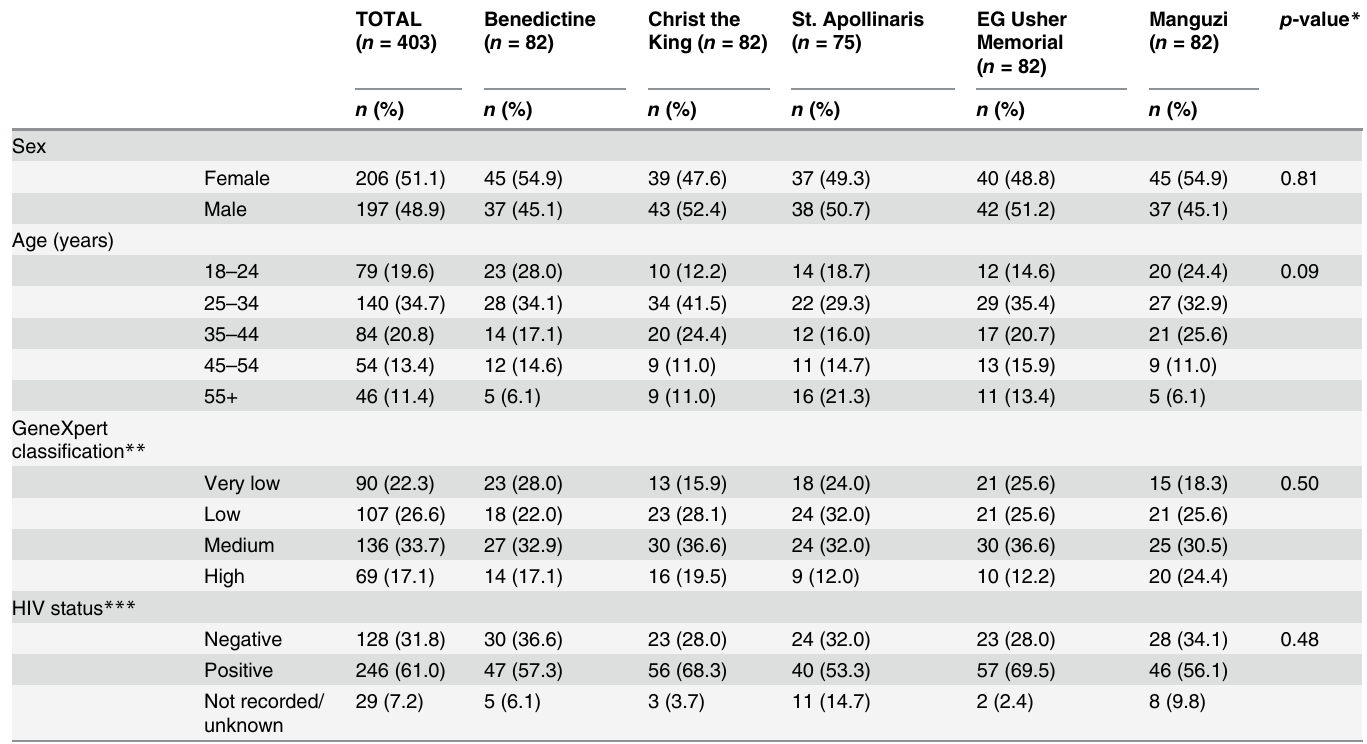
Table 5. Participant characteristics at retrospective sites, KwaZulu-Natal Province, South Africa (n = 403).